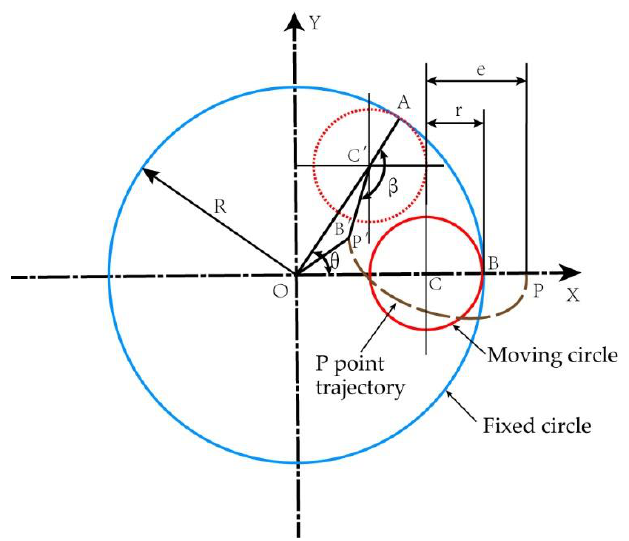
Figure 2. Schematic drawing of a hypocycloid.